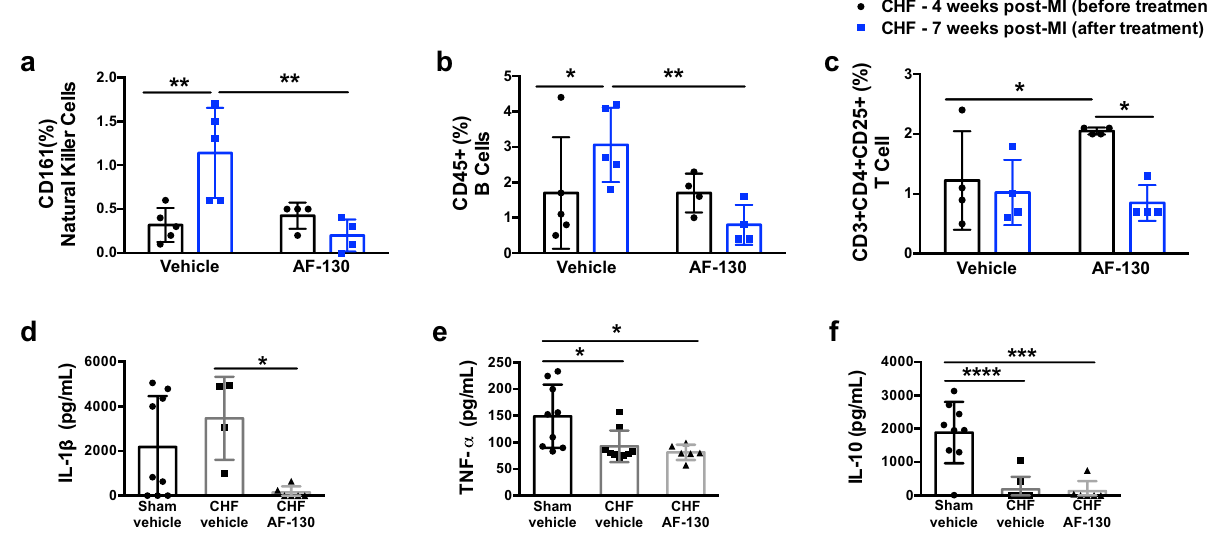
Fig. 7 | P2X3 receptor blockade reduces the immune cell response and plasma cytokine levels in chronic heart failure (CHF) rats. Quantitative data for natural killer cells (CD161, a ), B cells (CD45+, b ) and T cells (CD3+CD4+CD25+, c ). These speci fi c immune cell types were suppressed by antagonizing P2X3 receptors sys- temically in CHFrats. The immune cells wereanalyzedafter three weeks ofvehicle ( n =5) or AF-130 ( n =4) administration. Two-way repeated measures ANOVA, with